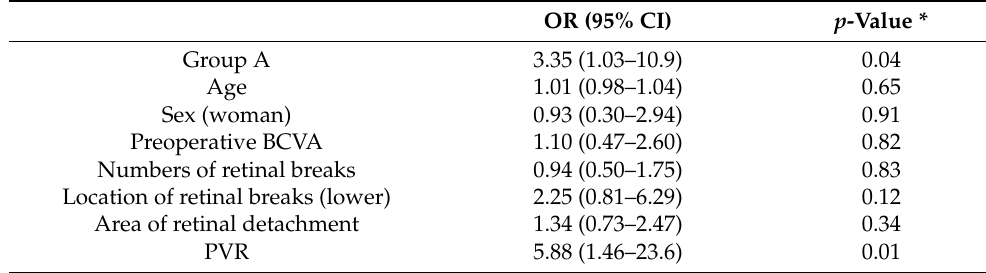
Table 3. Multivariate analysis of odd ratio (OR) for the initial failure of